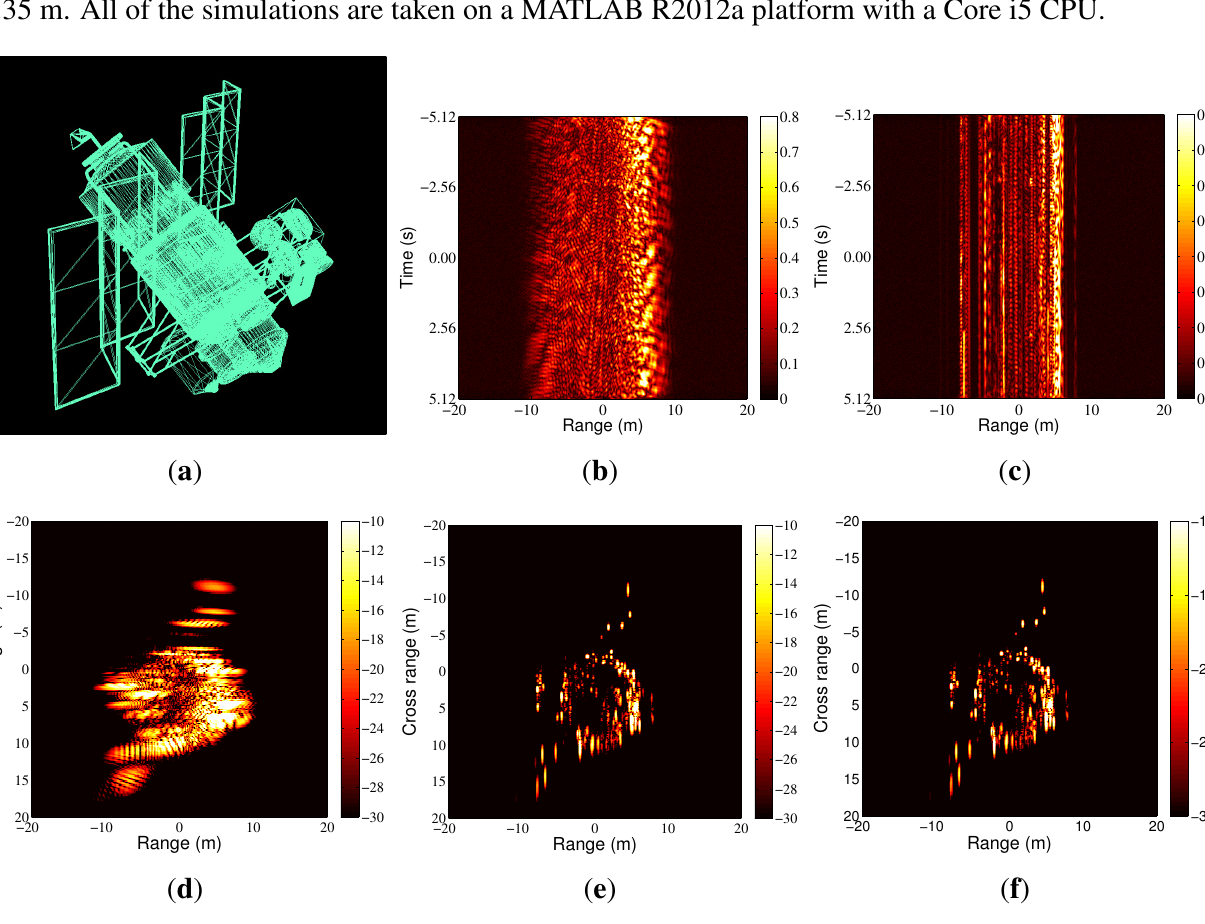
Figure 6. ISAR imaging simulation. ( a ) 3D satellite model; ( b ) LFM, the simulated range profiles; ( c ) HFM, the simulated range profiles; ( d ) LFM, the range-Doppler (RD) imaging result without velocity compensation; ( e ) LFM, the RD imaging result with velocity compensation by integrated cubic phase function (ICPF); ( f ) HFM, the RD imaging